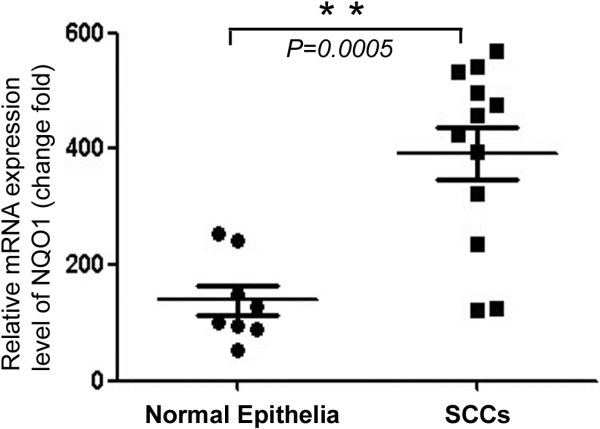
QRT-PCR analysis of NQO1 mRNA. Twelve cases of cervical SCC and eight cases of normal fresh cervical tissue were collected and subjected to qRT-PCR analysis of NQO1 mRNA levels. Data represent the mean of individual samples tested in triplicate relative to that of the normal control ± SD (P < 0.05).